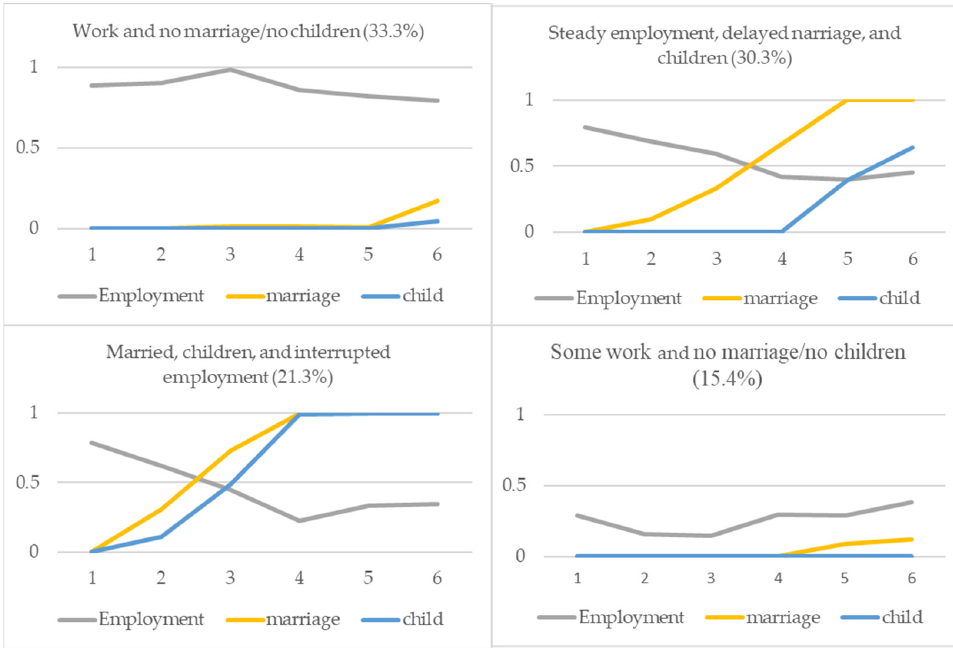
Figure 1. Unmarried women’s work and family pathways.